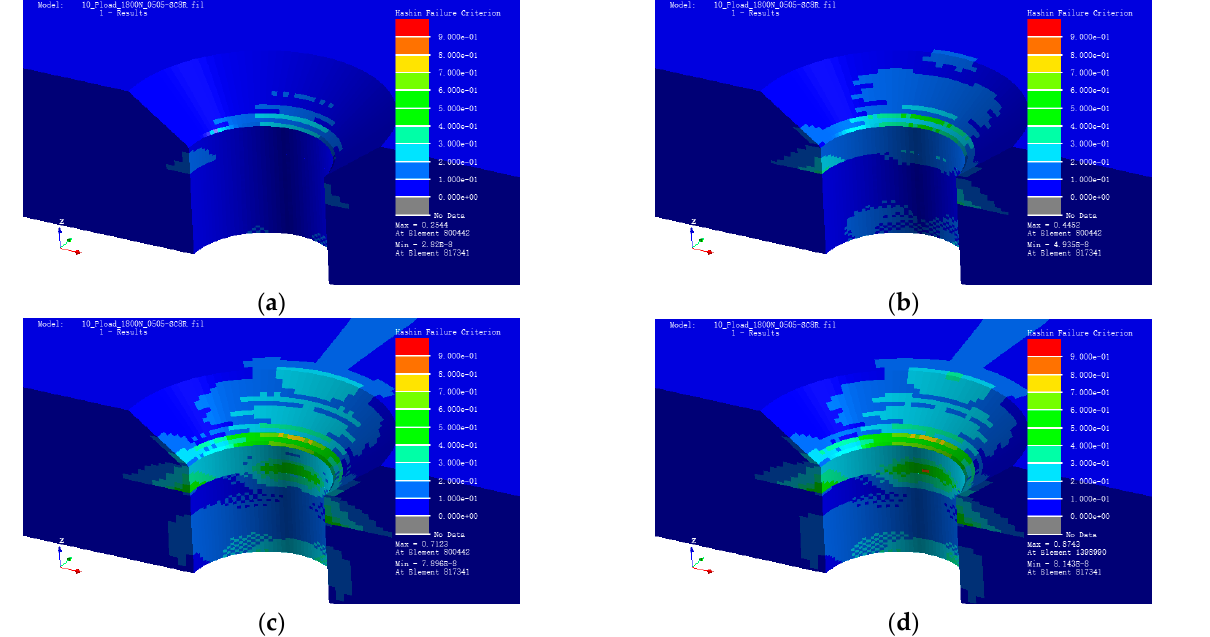
Figure 8. Laminate damage. ( a ) Laminate damage after 10 3 cycles. Hashin damage value 0.254. ( b ) Laminate damage after 10 4 cycles. Hashin damage value 0.445. ( c ) Laminate damage after 10 5 cycles. Hashin damage value 0.712. ( d ) Laminate damage after 10 6 cycles. Hashin damage value 0.874.